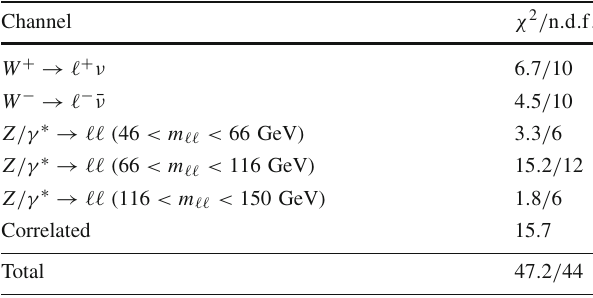
Table 11 Partial and total χ 2 / n . d . f . for the combination of the differ- ential d σ/ d | η (cid:3) | and d σ/ d | y (cid:3)(cid:3) | cross sections. The contribution of the penalty term constraining the shifts of correlated uncertainties is listed separately in the row labelled “Correlated”, see Eq. (11) Channel χ 2 / n . d . f